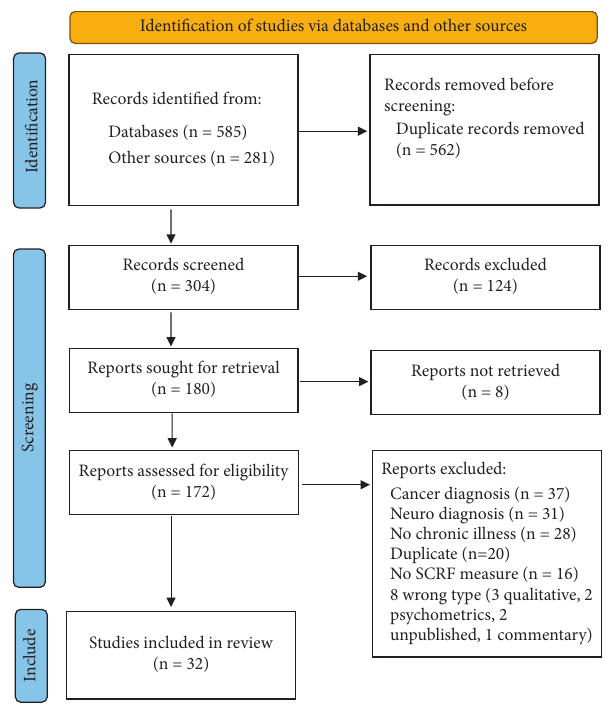
Figure 1: PRISMA flow